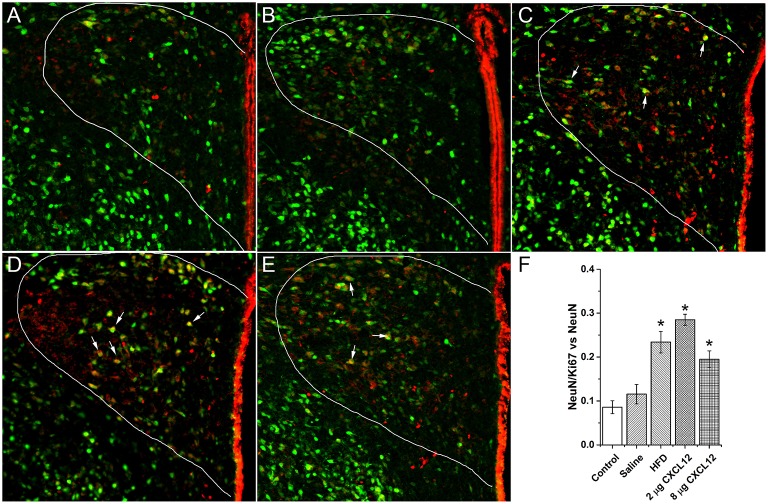
Prenatal HFD and CXCL12 increased neurogenesis in the PVN. Representative photomicrographs of neurons double-labeled with NeuN and Ki67 from the PVN of P15 offspring under the following prenatal conditions: (A) negative control rats; (B) saline injected rats; (C) HFD exposed rats; (D) 2 μg CXCL12 exposed rats; and (E) 8 μg CXCL12 exposed rats. The white arrows depict neurons positive for both NeuN and Ki67. (F) Prenatal exposure to a HFD, 2 or 8 μg CXCL12, significantly increased the number of double-labeled NeuN/Ki67 neurons as compared to control. *p < 0.05 vs. control.